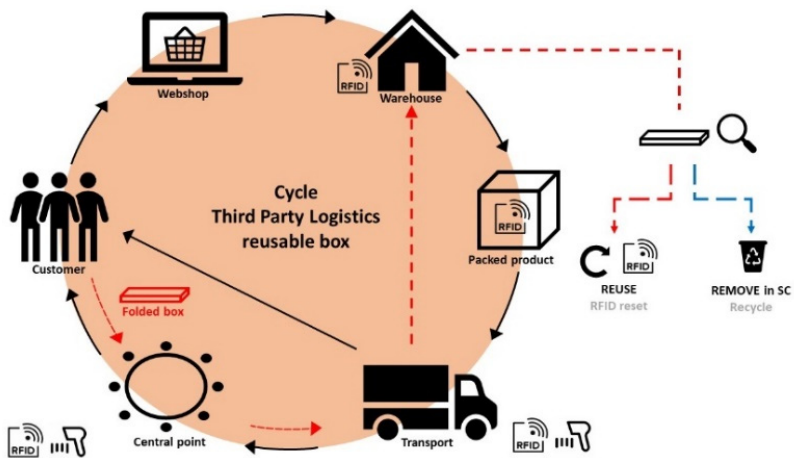
Figure 1. Cycle of reusable packaging within third-party logistics. E-fulfilment covers the essential arrangements for stakeholders to sell their